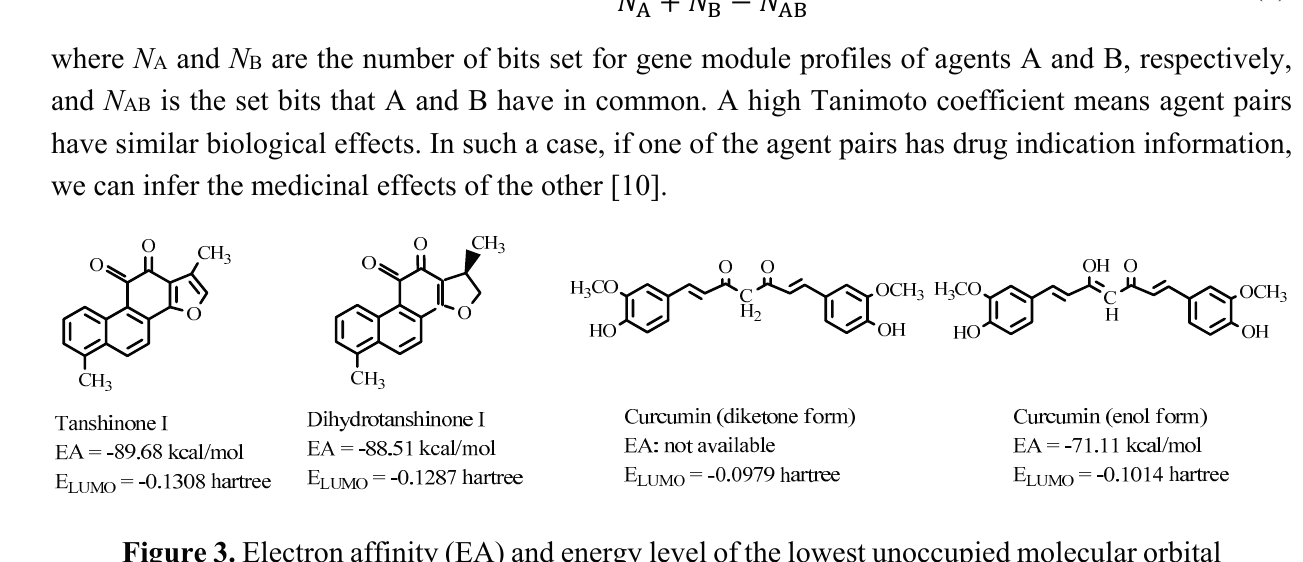
Figure 3. Electron affinity (EA) and energy level of the lowest unoccupied molecular orbital (E LUMO ) of tanshinones and curcumin calculated at B3LYP/6-31+G(d) level. The data of tanshinones are from